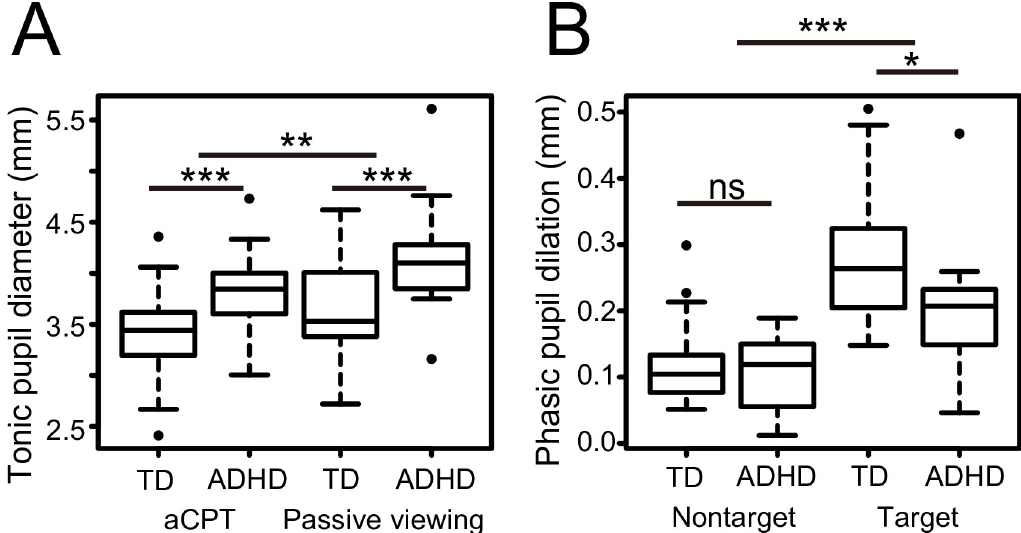
Fig 2. Tonic and phasic pupil diameters in the TD and ADHD groups. (A) Tonic pupil diameter during the passive-viewing condition and the auditory CPT. To estimate tonic pupil diameter, we calculated an average pupil diameter in the period from -1 to 0 s before the stimulus presentation. We calculated phasic pupil dilation during one trial by detecting pupil diameter maxima in a time window between 4 s after stimulus (target, nontarget) onset. (B) Maximum pupil diameter in response to the target and the nontarget tones. These were assessed for statistically significant differences with a mixed-model ANCOVA or ANOVA. � p < .05, �� p < .001, ��� p < .0001, ns, not significant. https://doi.org/10.1371/journal.pone.0244662.g002 Both the TD and ADHD groups had transient dilatory responses in pupil diameter after stimulus onset. We compared the phasic pupil dilation in response to the stimulus tones between groups (mean 0.28 mm (target, TD), 0.12 mm (nontarget, TD), 0.20 mm (target, ADHD), 0.11 mm (nontarget, ADHD)) ( Fig 2B ). A mixed-model analysis of variance (ANOVA) with the factors group and stimulus (target vs. nontarget) demonstrated that there was no main effect of group ( F (1, 36) = 3.7, p = .06), but a significant main effect of stimulus ( F (1, 36) = 146.0, p < .001). Furthermore, there was a significant interaction between group and stimulus ( F (1, 36) = 9.6, p < .005). When the responses were subgrouped according to target vs. nontarget trials, only responses to target trials were significantly different (target, F (1, 36) = Table 1. Characteristics of the participants.